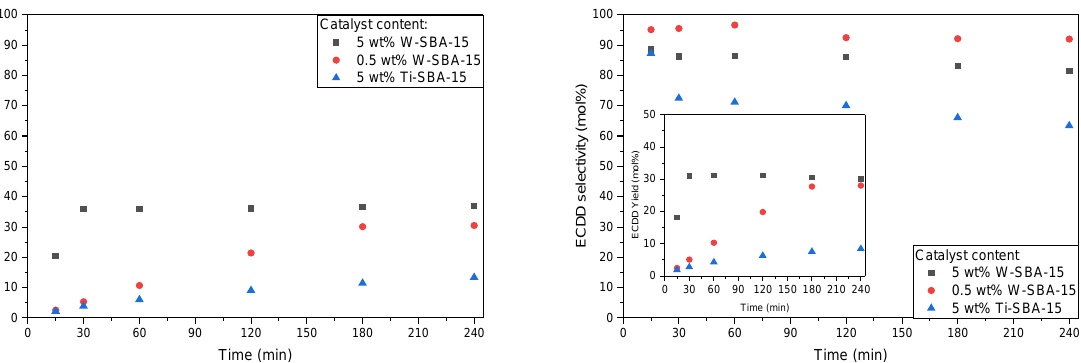
Figure 7. Graphs showing conversion of CDT ( left ), selectivity of transformation of CDT to ECDD ( right , main), and ECDD yield in relation to CDT ( right , insert) with different catalysts and catalyst contents. Reaction conditions: temperature, 60 °C; solvent, i-PrOH, 90 wt%; CDT:H 2 O 2 (60 wt% aqueous solution) molar ratio, 2.